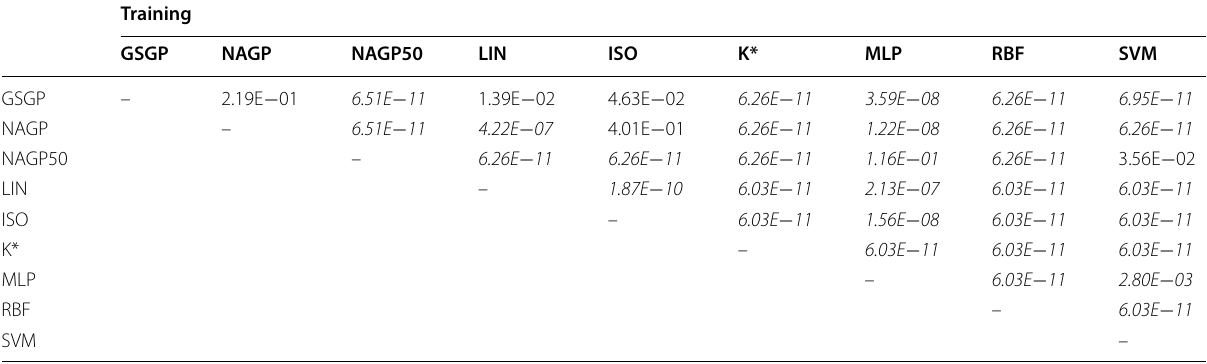
Table 5 p -values returned by the Mann–Whitney U-test for the results achieved on the training set.